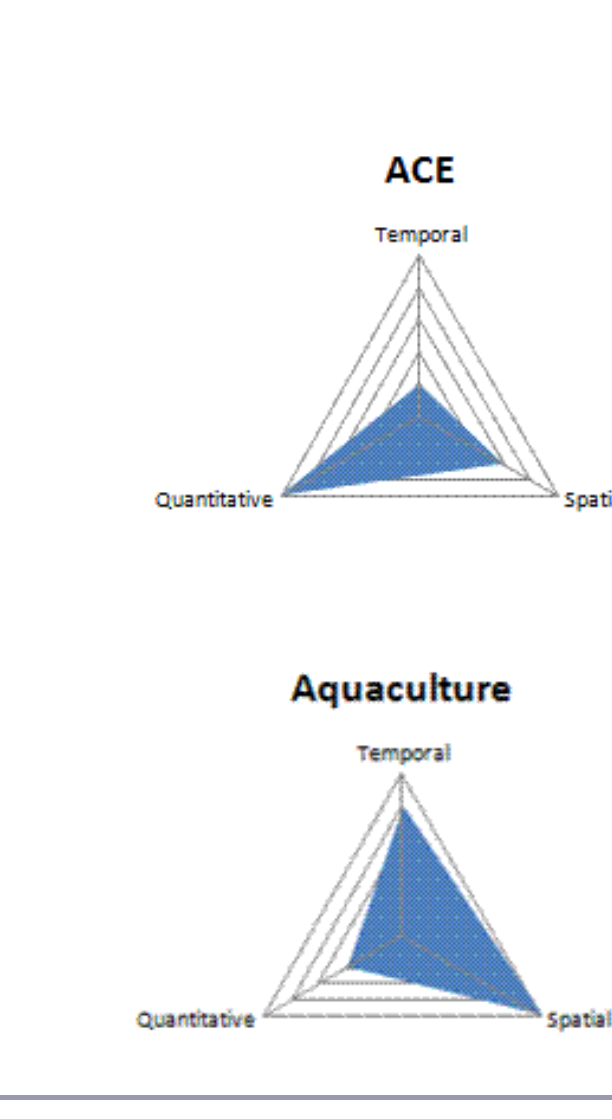
Fig. 2. Comparison of property rights dimensions for individual transferable quotas (ITQs), annual catch entitlement (ACE), recreational fishers, and